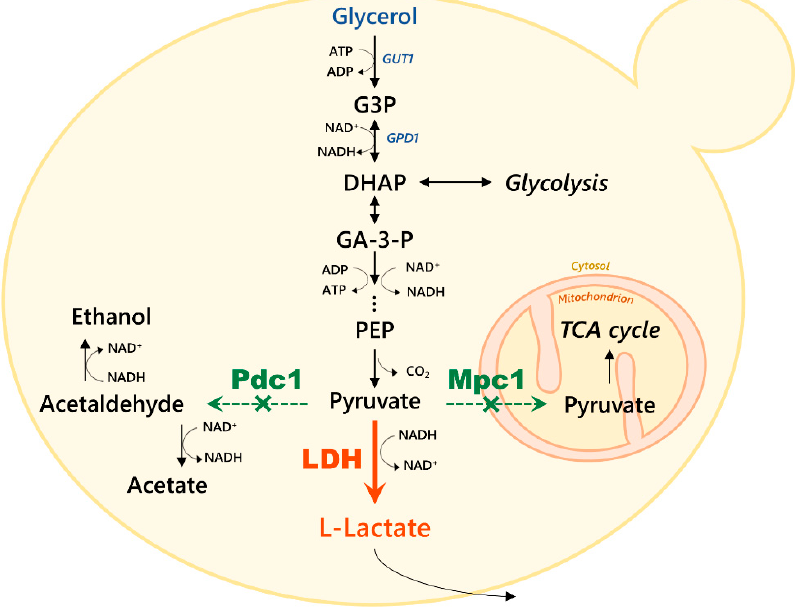
Figure 1. Genetic modifications of the K. phaffii GLpm strain. Endogenous genes of the glycerol assimilation pathway are highlighted in blue. The bovine lactate dehydrogenase is depicted in orange [12]. The targets of knockout, PDC1 [19] and MPC1 are shown in green. GUT1, glycerol kinase; GPD1, glycerol 3-phosphate dehydrogenase; LDH, lactate dehydrogenase; Mpc1, mitochondrial pyruvate carrier; Pdc1, pyruvate decarboxylase; G3P, glycerol-3-phosphate; DHAP, dihydroxyacetone phosphate; GA-3-P, glyceraldehyde 3-phophate; PEP, phosphoenolpyruvate.